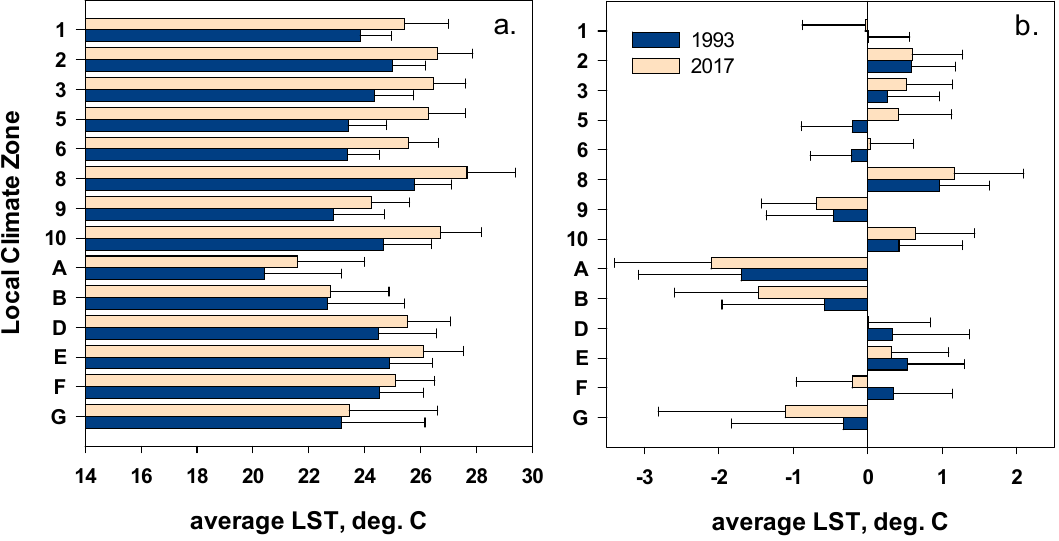
Figure 7. Summer-average mean Landsat brightness temperature for mapped LCZs in the Salt Lake Figure 7. Mean Landsat land surface temperature (LST) values for mapped LCZs in the Salt Lake City, City, UT, USA study area in 1993 and 2017. Error bars show standard deviation in temperature UT, USA study area in 1993 and 2017: ( a ) annual average LST, and ( b ) normalized annual average LST. within LCZs. Error bars show standard deviation of temperature metrics within